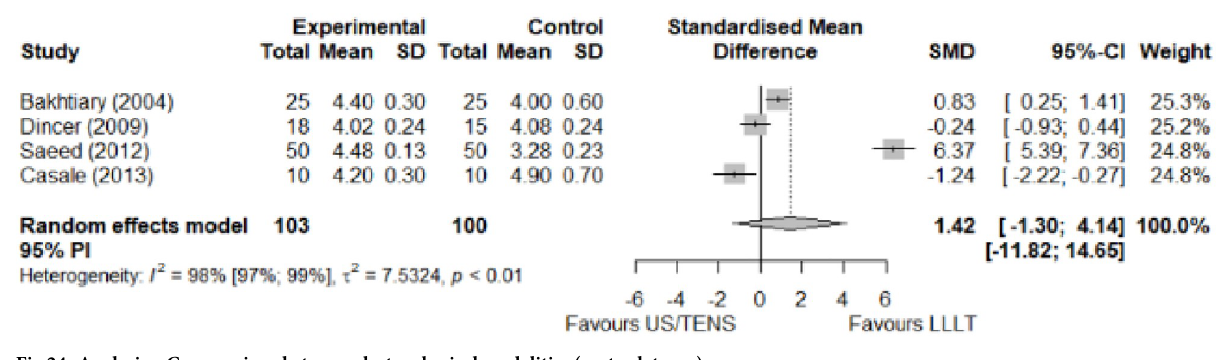
Fig 24. Analysis—Ccomparison between electrophysical modalities (motor latency).